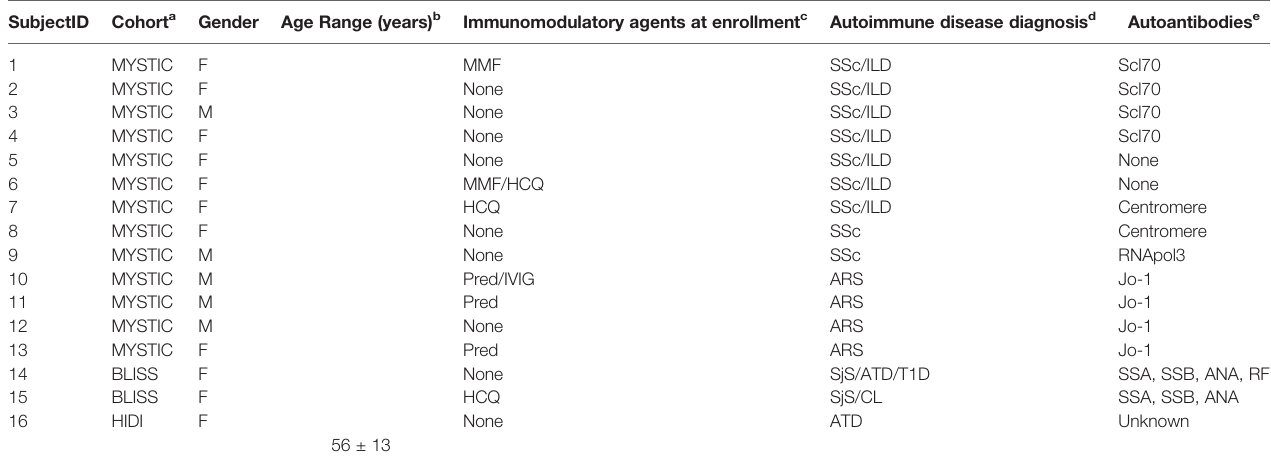
TABLE 1 | Demographics for participants included from MYSTIC, BLISS, and HIDI cohorts.